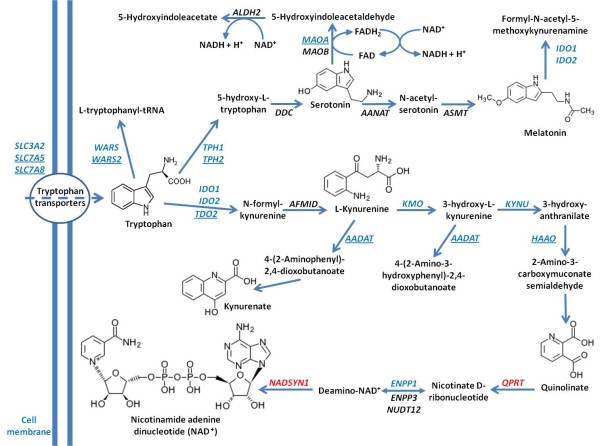
Tryptophan pathways. The figure illustrates the main intracellular pathways involving tryptophan. Genes with reduced expression in our microarray dataset are in blue, genes with increased expression are in red. Genes with statistically significant reduction of expression are underlined. Reactions generating NADH are indicated in the top section of the figure. FAD, flavin adenine dinucleotide.